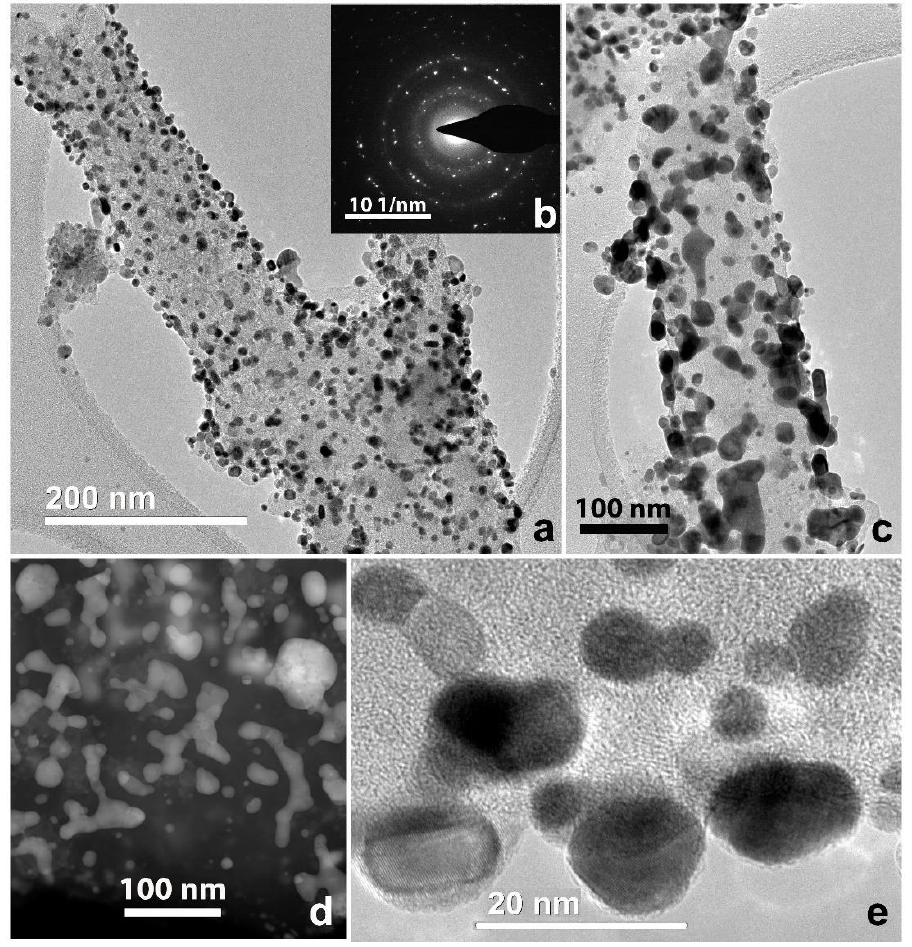
Figure 10. Structure of Pt / 1’ (after working in MEA): ( a ) general view and ( b ) corresponding SAED pattern; ( c ) changed morphology of Pt crystals; ( d ) HAADF STEM images of polycrystalline particles; ( e ) HRTEM image of particles.